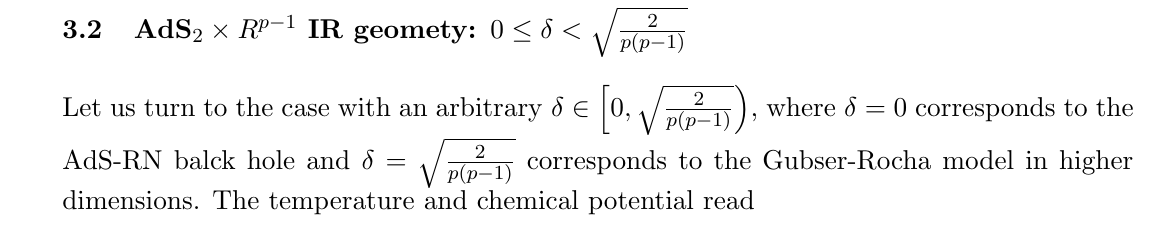
which agrees with (3.23). In short, the origin of the linear- T dependence of (cid:22) (cid:27) momentum relaxation comes from the combination of (cid:27) The exact plots of the resistivity (3.15) are shown in (cid:12)gure 4 for p = 4 ; 5 and (cid:22) (cid:12) = 1 ; 10 ; 20. As expected, the large (cid:22) (cid:12) gives a robust linear- T resistivity. The slop at small temperature agrees with (3.20) (or (3.23) for (cid:22) (cid:12) = 10 ;